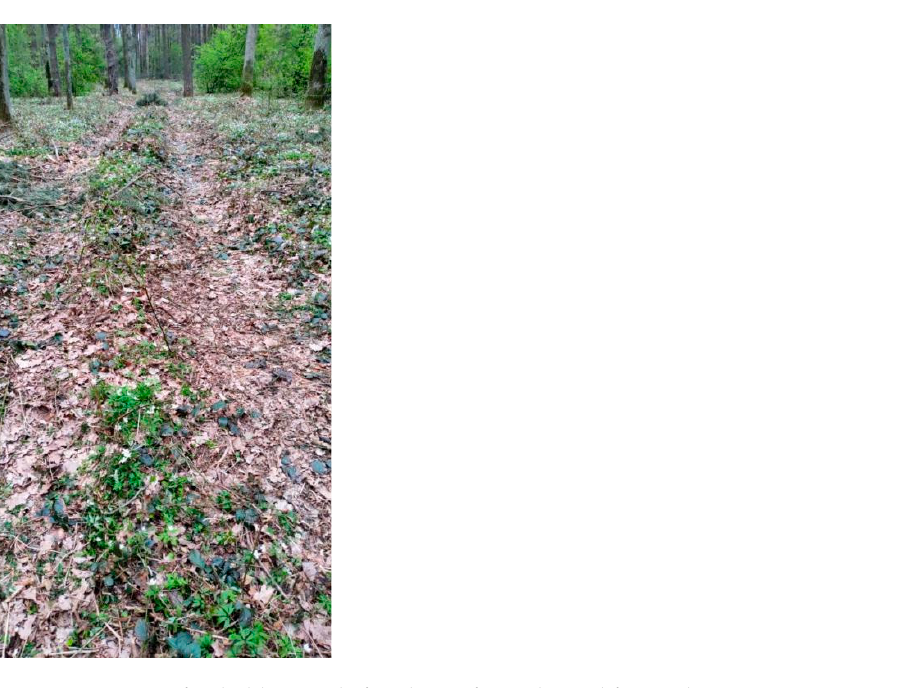
Figure 1. An image of a skidding trail after the performed wood forwarding operation.